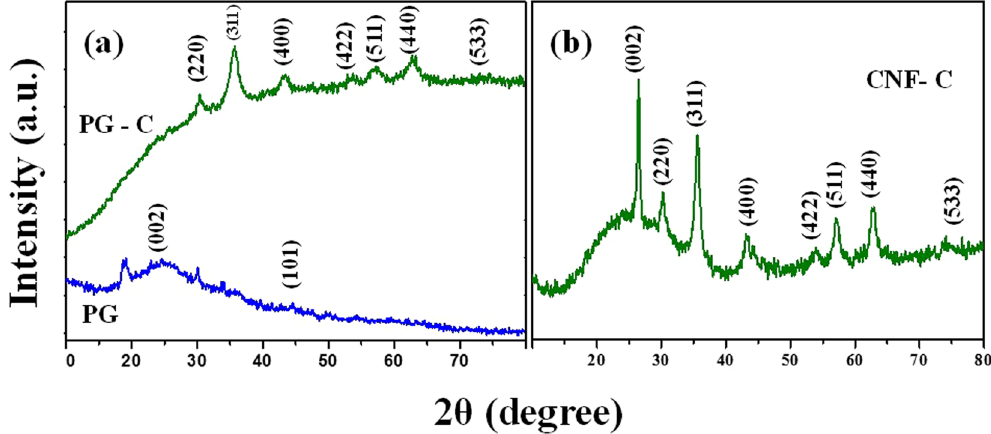
Figure 1. ( a ) XRD analysis of porous graphene (PG) and porous graphene – CoFe 2 O 4 (PG-C) and ( b ) carbon nanofiber – CoFe 2 O 4